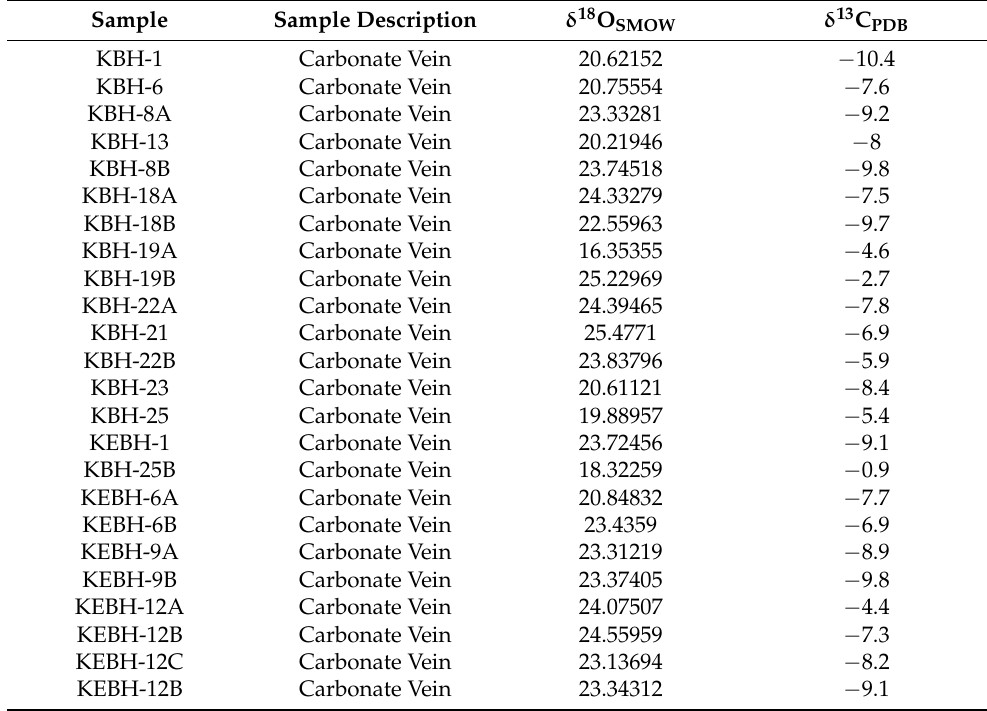
Table 1. Carbon and oxygen isotope data from mineralized carbonate vein samples from Mundi- yawas-Khera copper deposit.